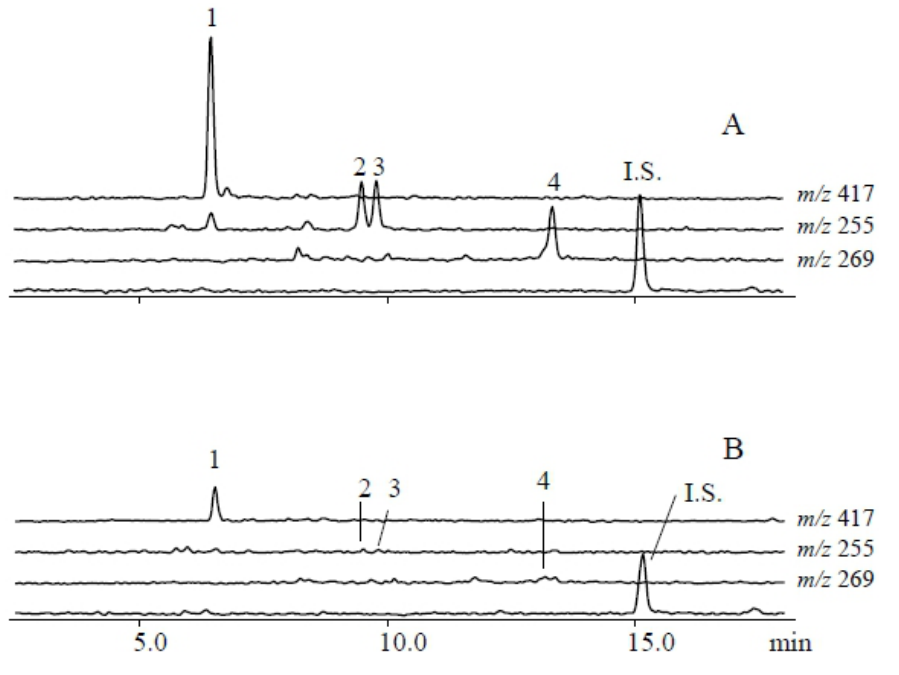
Figure 3. S. litura herbivory and gut content elicitation of soybean leaves results in an array of induced flavonoids. Structures and reference numbers (1–7) of compounds identified in the current study are as follows: (1) daidzin; (2) 4’,7-dihydroxyflavone; (3) daidzein; (4) formononetin; (5) malonyldaidzin; (6) ononin; and (7)